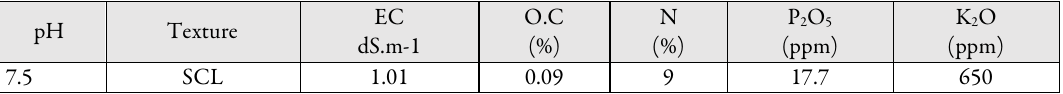
Table 1. The analysis of pH, texture, organic carbon, nitrogen, phosphor and potassium of soil of study pH